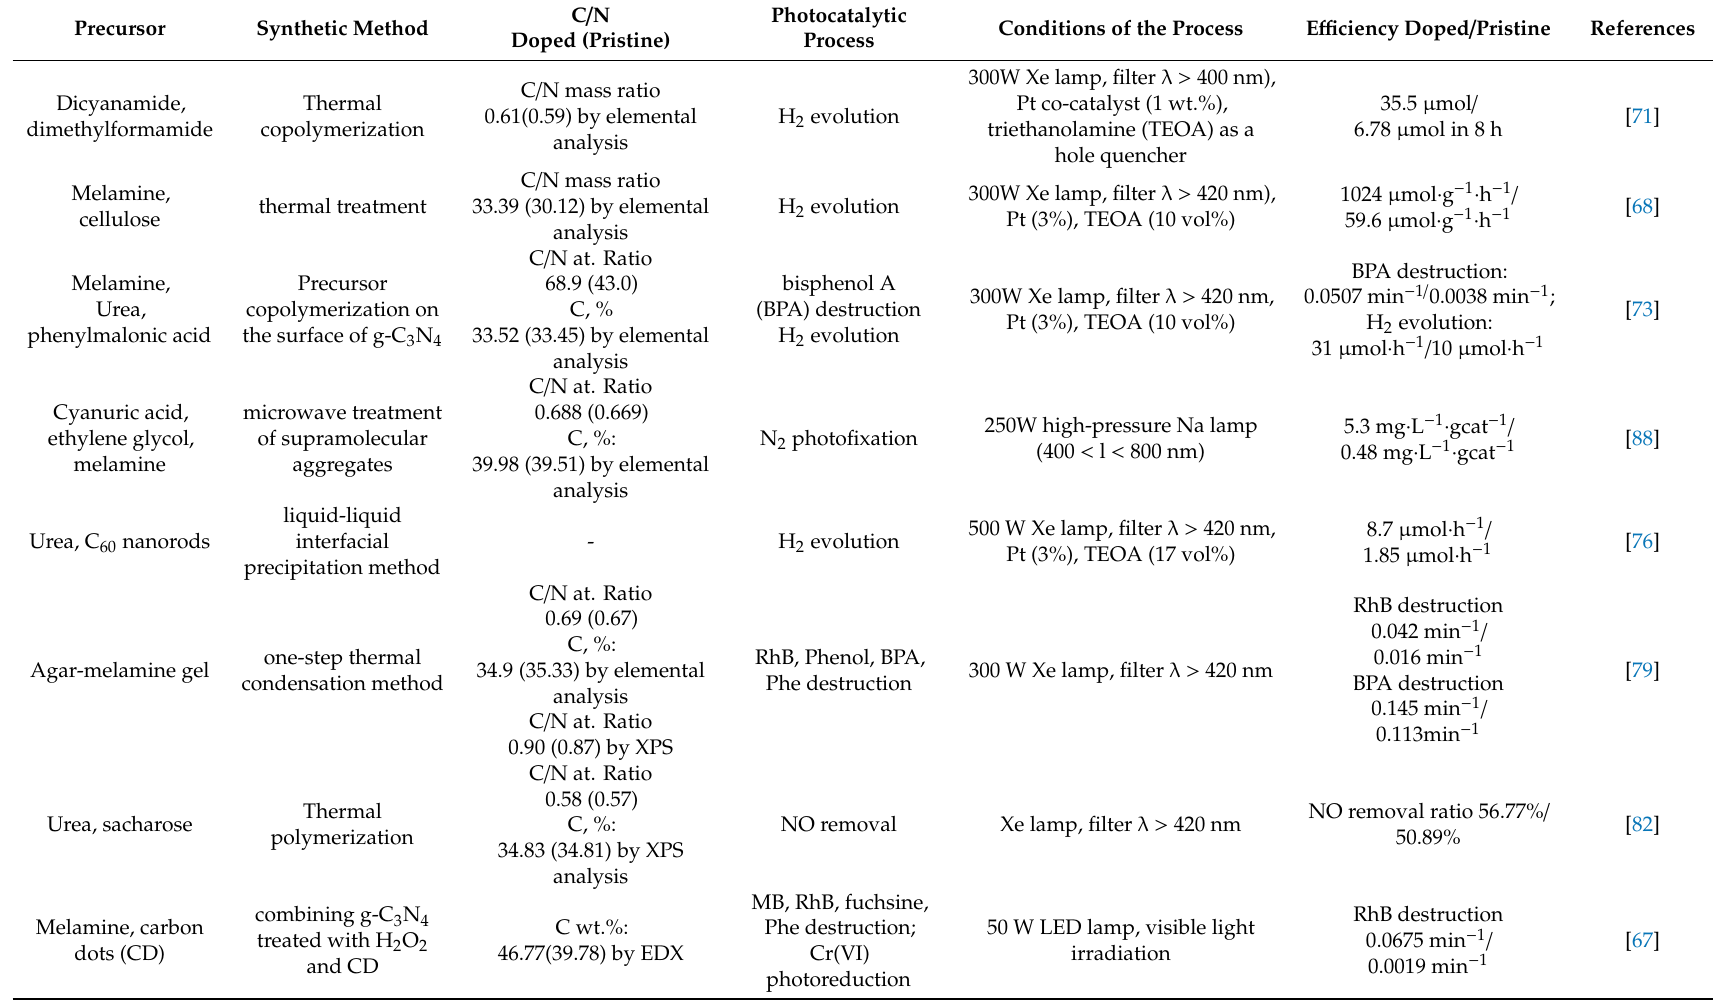
Table 3. Synthetic methods, applications, and photocatalytic e ffi ciency of C-doped g-C 3 N 4